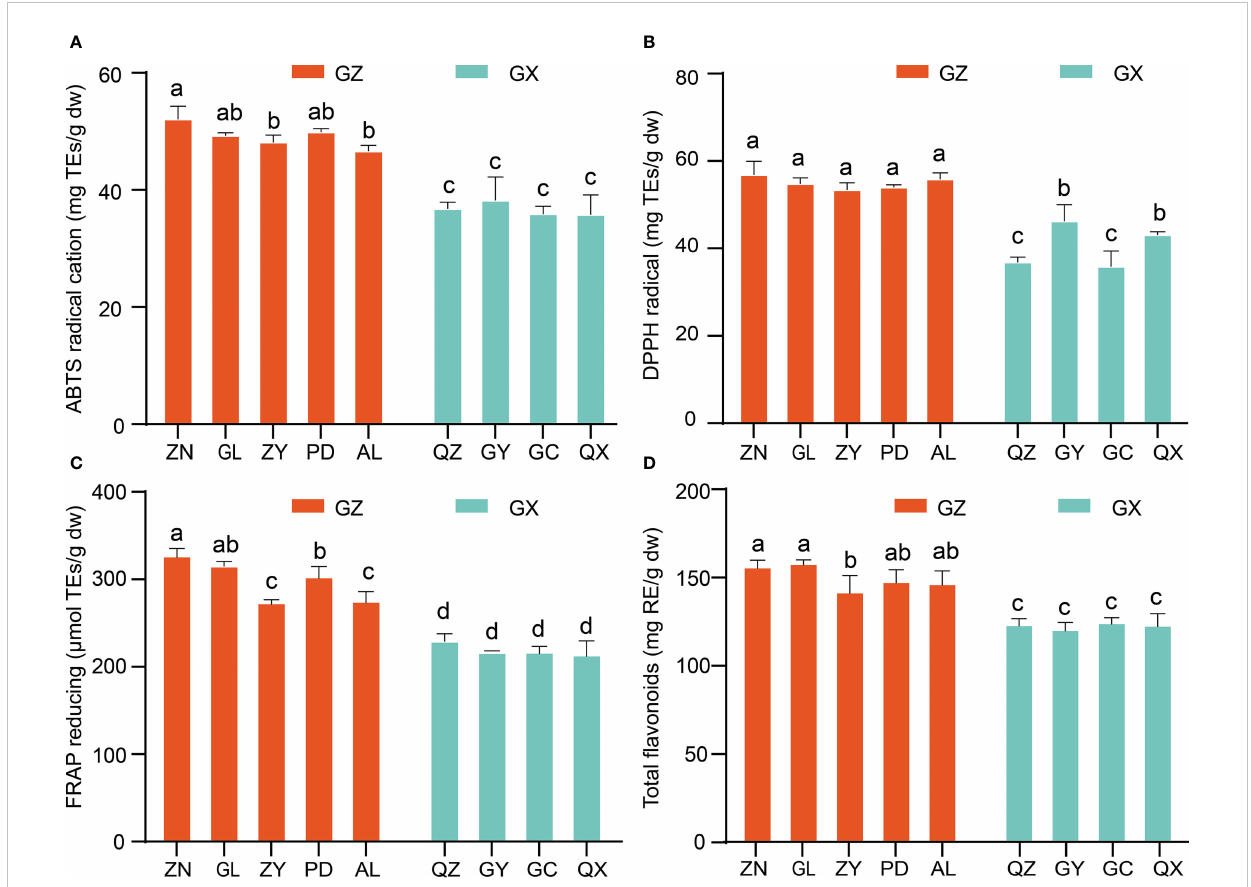
FIGURE 5 In vitro antioxidant activities and total fl avonoid content of P. petiolosa samples from different geographical origins. (A) ABTS radical scavenging